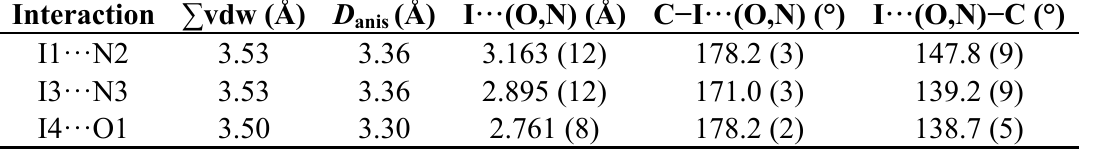
Table 4. Structural characteristics of the halogen bonding interactions